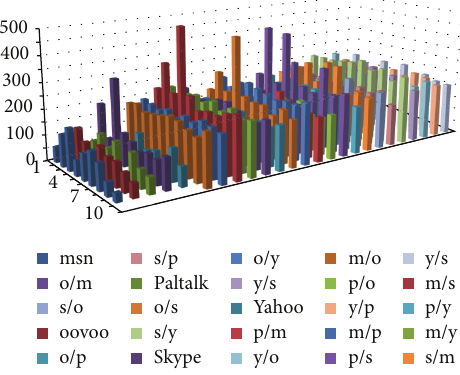
Figure 15: Experimental results of histogram method.